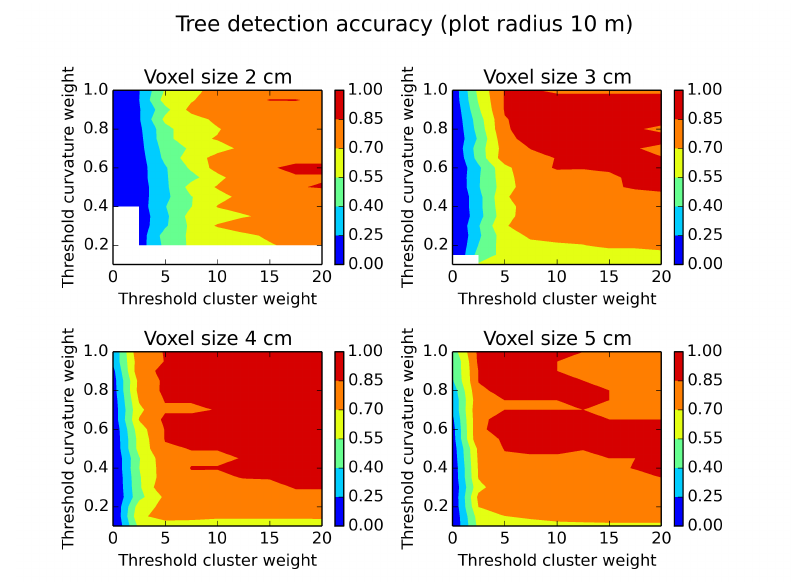
Figure 8. Tree detection accuracy evaluated on a plot of a radius of 10 m and different parameter settings. White areas indicate missing data. High threshold parameter settings give high tree detection accuracy, with the exception of a voxel size of 5 cm, which is optimal with medium threshold parameter settings.